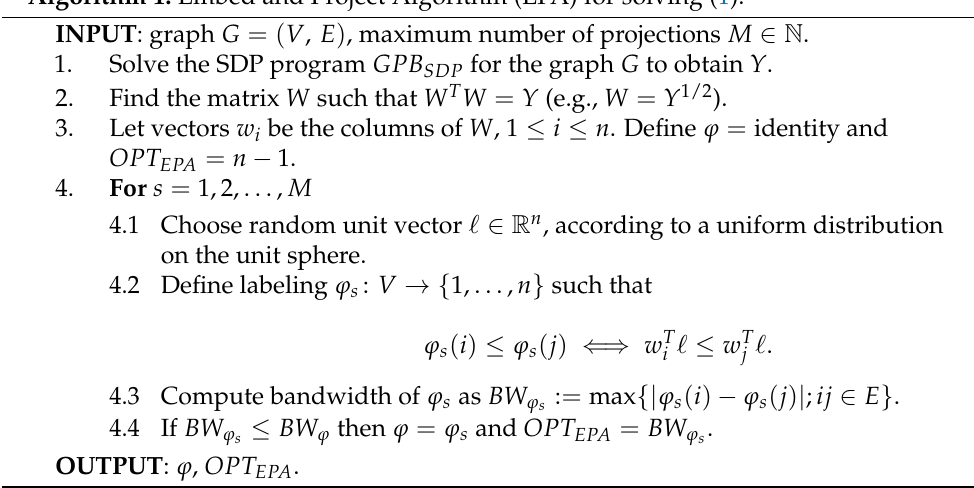
Algorithm 1: Embed and Project Algorithm (EPA) for solving